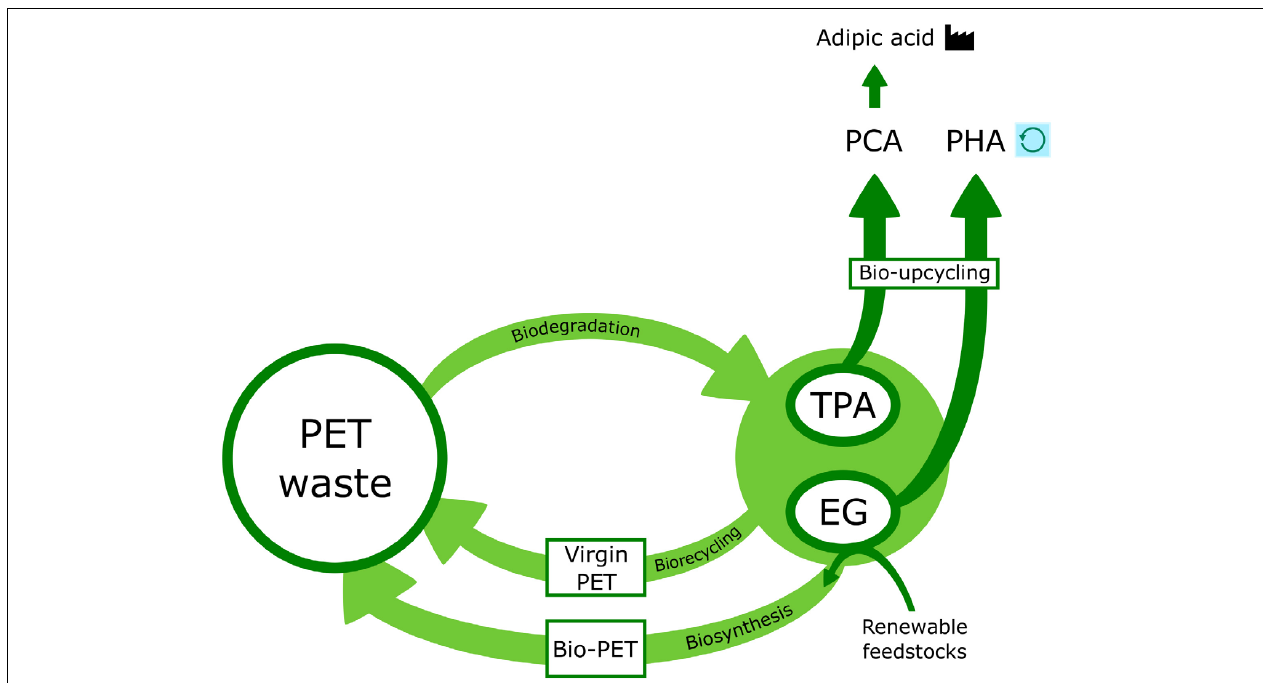
FIGURE 5 | Prospective overview of PET in the circular economy. Monomers resulting from biodegradation of PET may be recovered for manufacture of virgin PET (biorecycling) or combined with microbially synthesized monomers for a bio-based alternative (biosynthesis). Adipic acid, an important chemical precursor used primarily in nylon production, and polyhydroxyalkanoates (PHAs), which are both bio-based and biodegradable, are among the value-added products that may be obtained through transformation of TPA and EG monomers